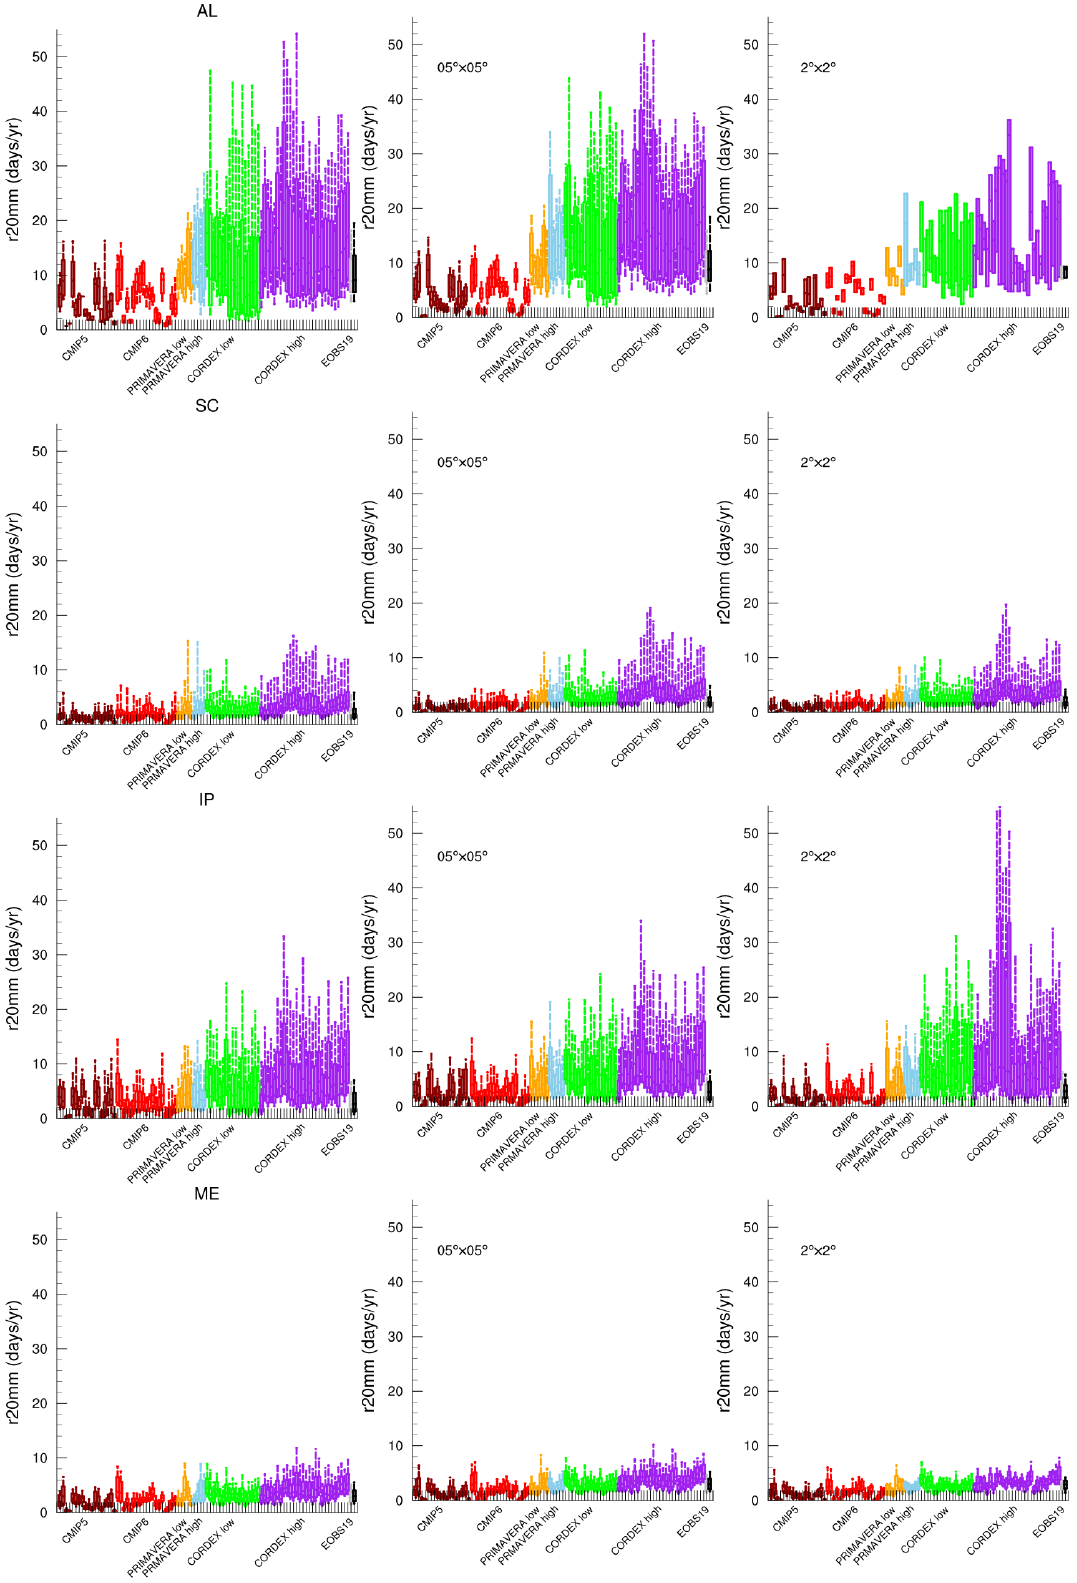
Figure 7. Same as Fig. 6 but for the number of days with precipitation amount over 20mm (R20mm, dyr − 1 ). Left column: model data on their original grids; centre column: all data regridded to 0 . 5 ◦ × 0 . 5 ◦ grid; right column: all data regridded to 2 ◦ × 2 ◦